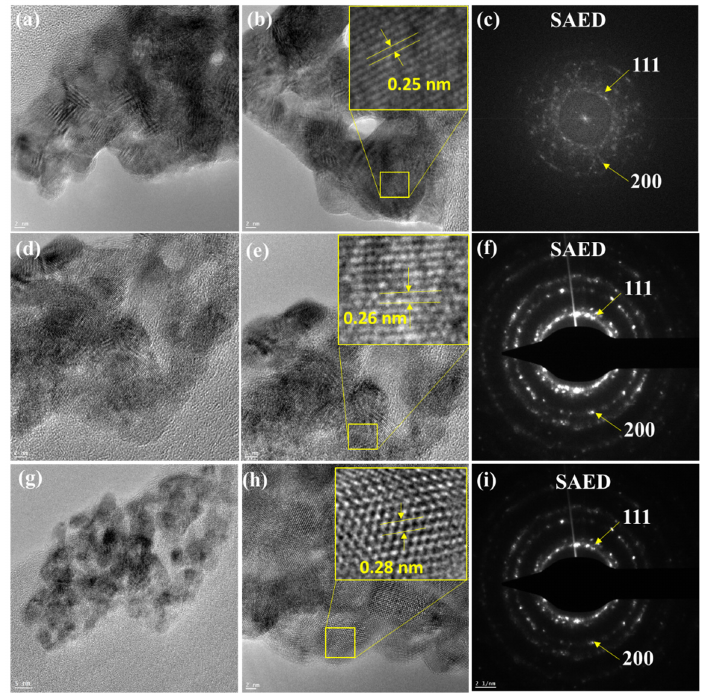
Figure 3. TEM images with SAED pattern for ( a – c ) Ni 0.85 Pd 0.15 , ( d – f ) Ni 0.80 Pd 0.20 , and ( g – i ) Ni 0.75 Pd 0.25 samples.